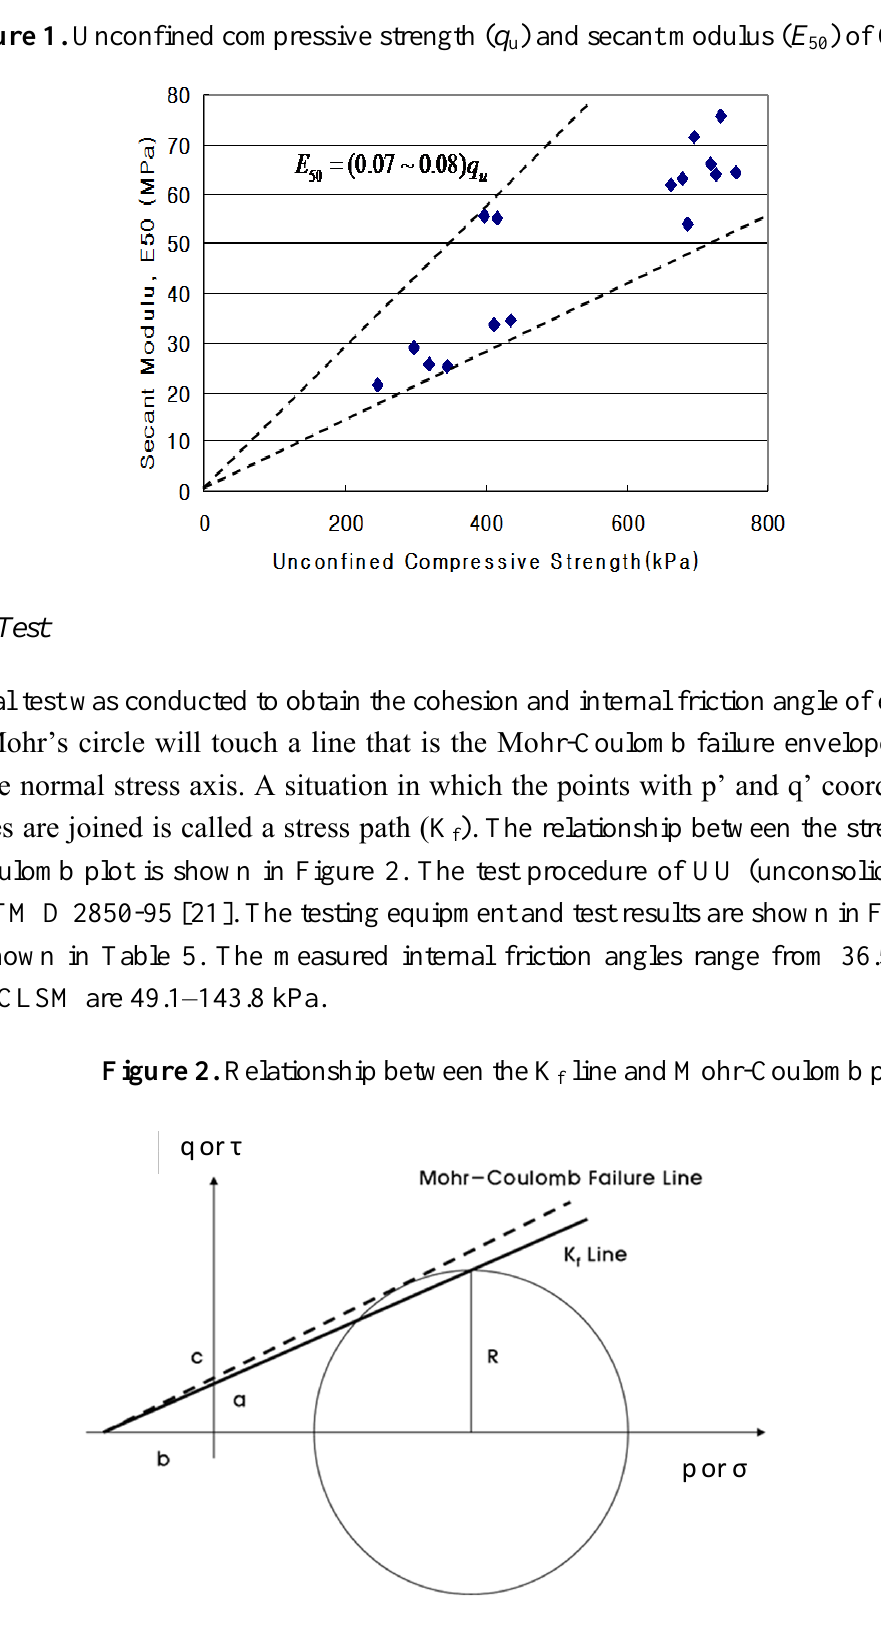
Figure 1. Unconfined compressive strength ( q